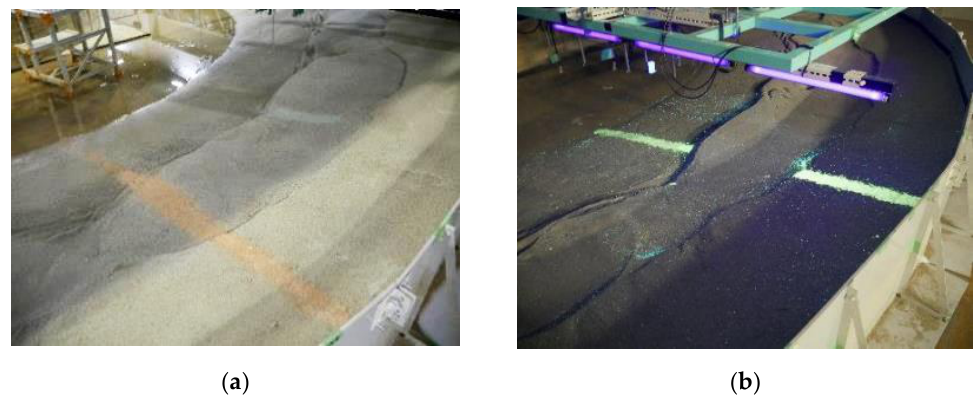
Figure 13. Snapshots of topography at the end of the experiments: ( a ) Case 1; ( b ) Case 1a.